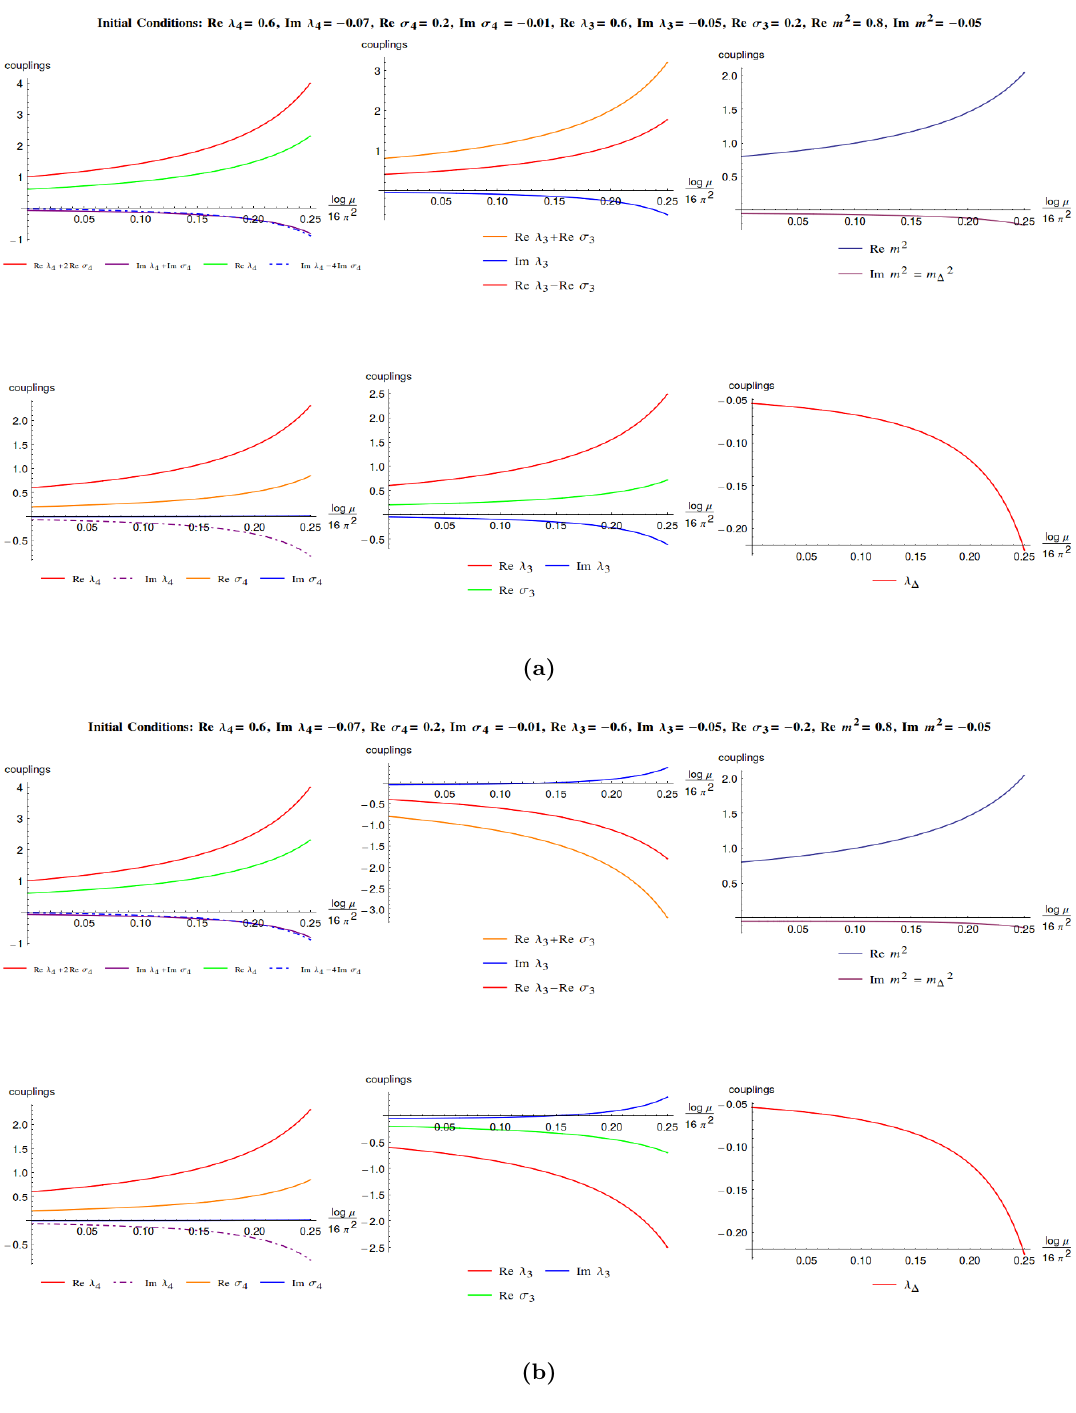
Figure 23. Figures showing the evolution of all the couplings for the case Re (cid:21) 4 + 2Re (cid:27) 4 > 0, Im (cid:21) 4 + Im (cid:27) 4 < 0 and the two subcases | Re (cid:21) 3 + Re (cid:27) 3 > 0 ((cid:12)gure a) and Re (cid:21) 3 + Re (cid:27) 3 < 0 ((cid:12)gure b).